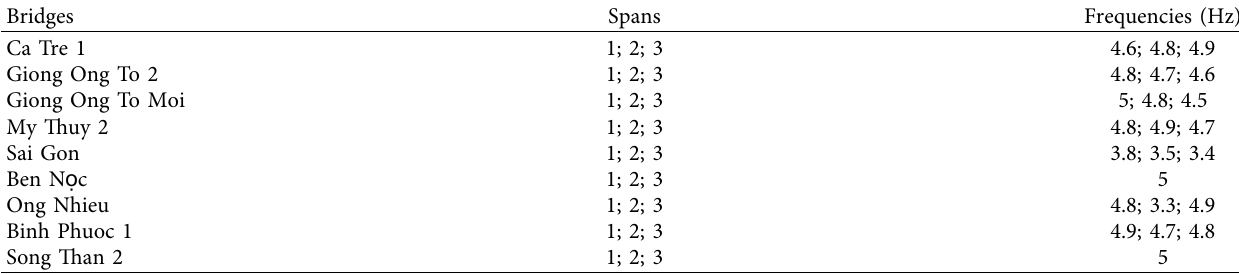
Table 11: Lowest natural frequencies of some prestressed concrete bridges.